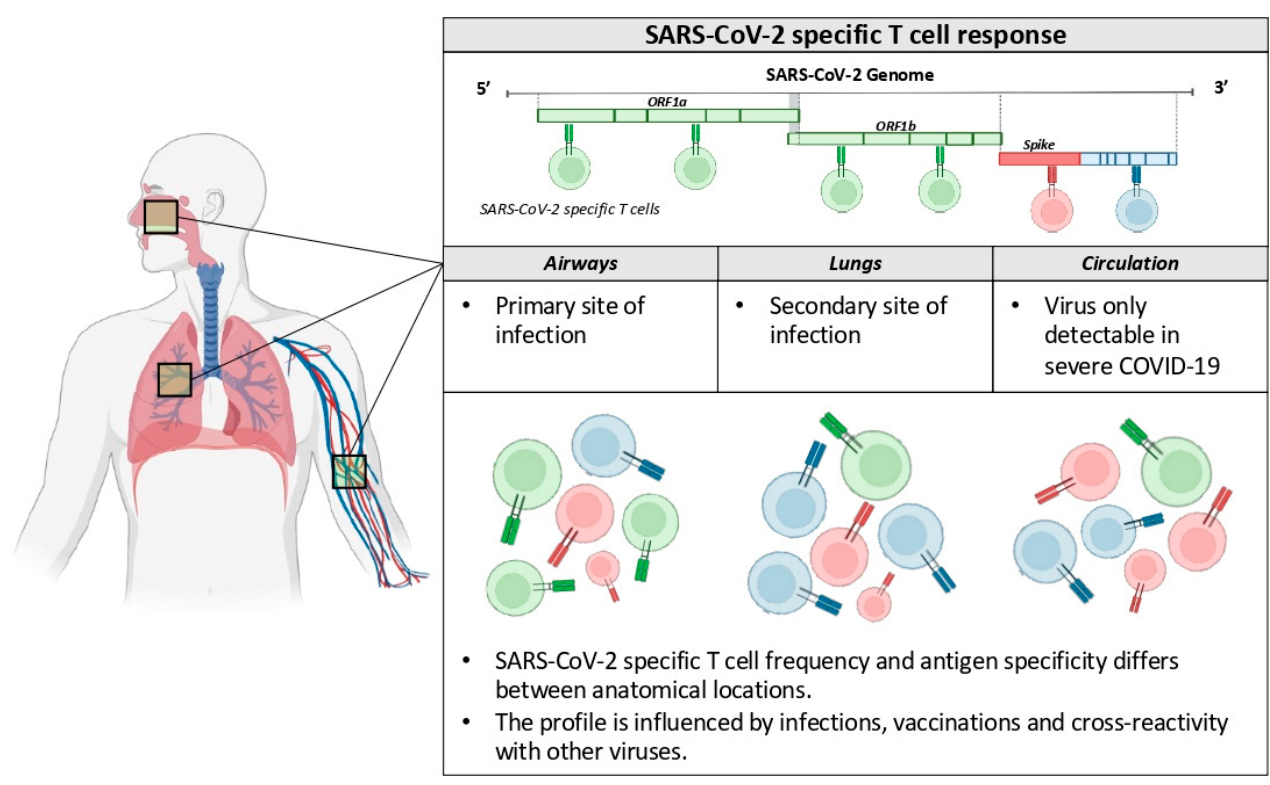
Figure 1. SARS-CoV-2-specific cellular immunity at different anatomical locations.